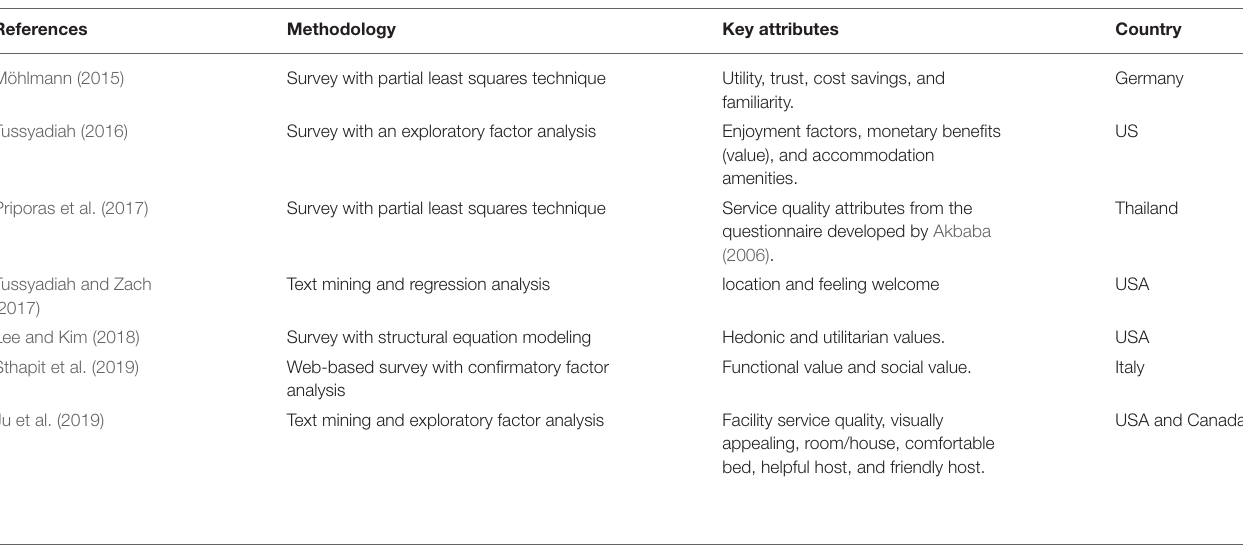
TABLE 1 | Summary of Airbnb satisfaction